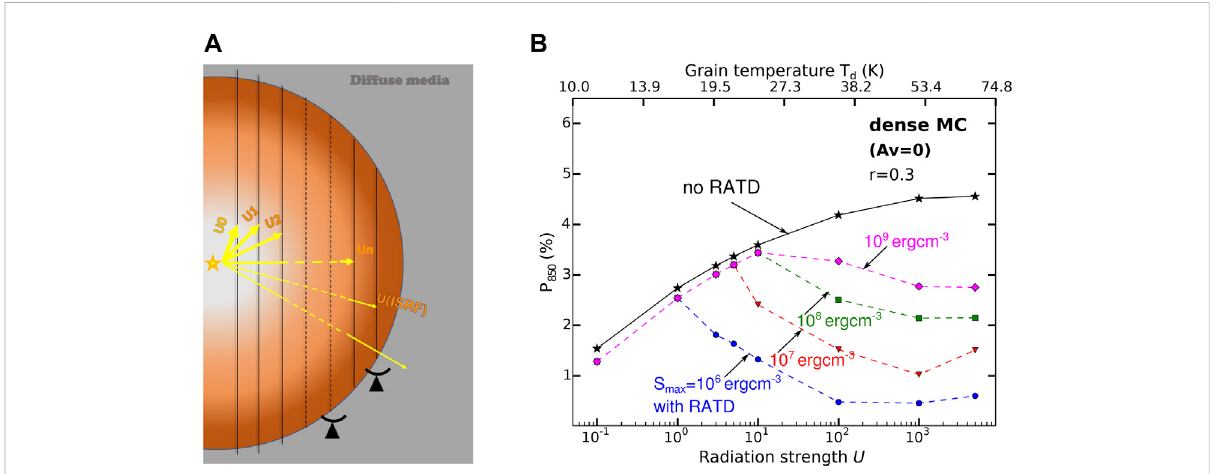
fi elds are assumed to beuniform. (B) An example of